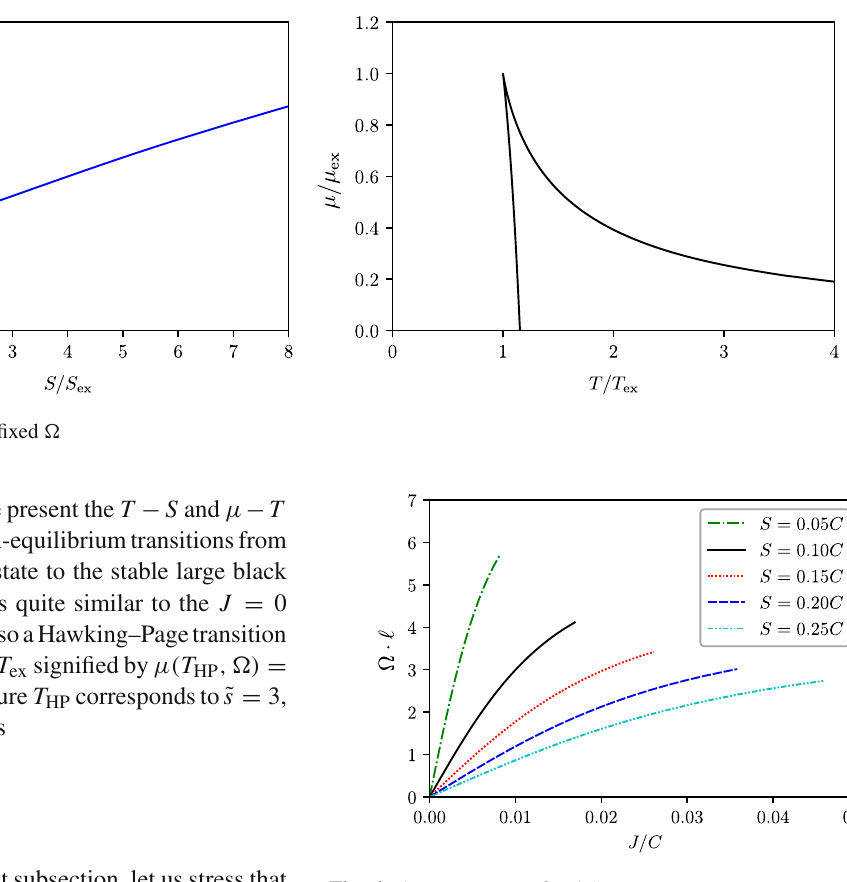
where S , J are both intensive quantities which are indepen- dent of C